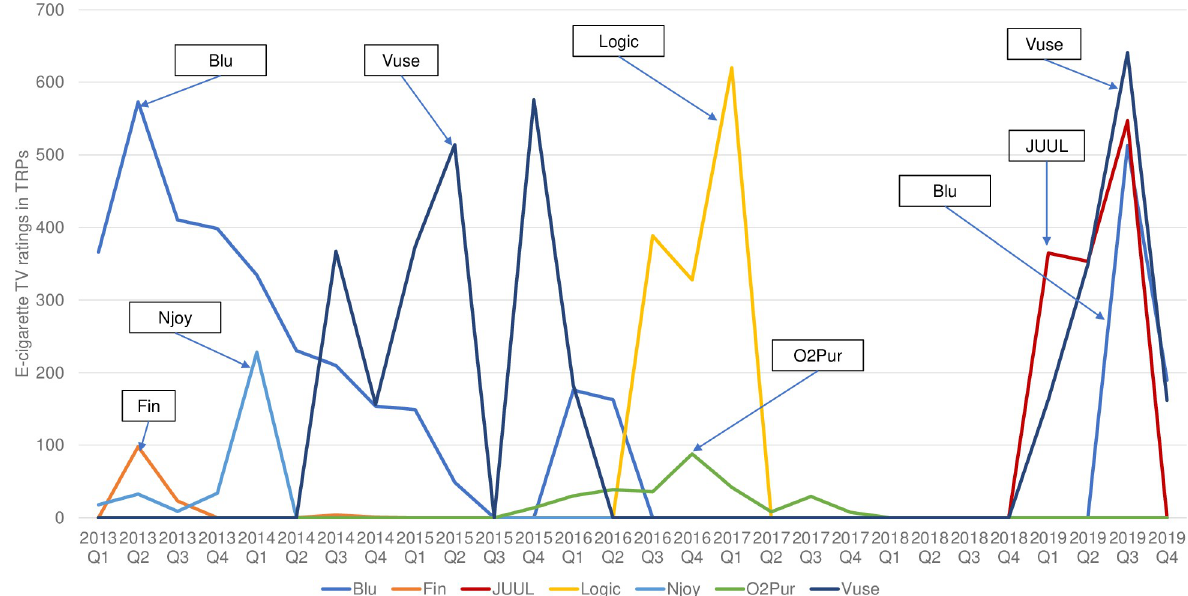
Fig 5. Adult (aged 18 and above) quarterly TV target rating points (TRPs) of the top 7 e-cigarette brands,